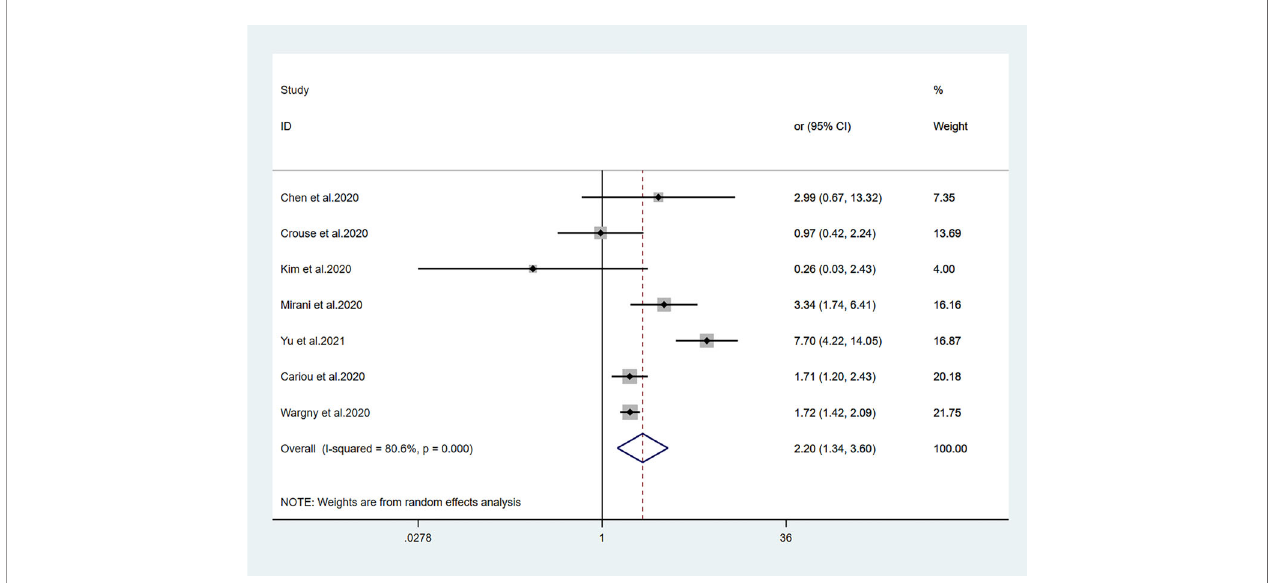
FIGURE 5 | Forest plots of meta-analysis of the relationship between insulin therapy and the risk of mortality in patients with type 2 diabetes who have COVID-19.